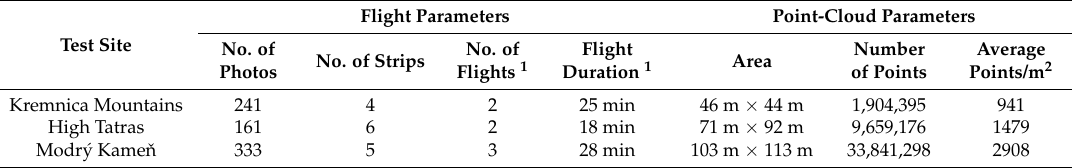
Table 2. Flight and point-cloud parameters according to the test